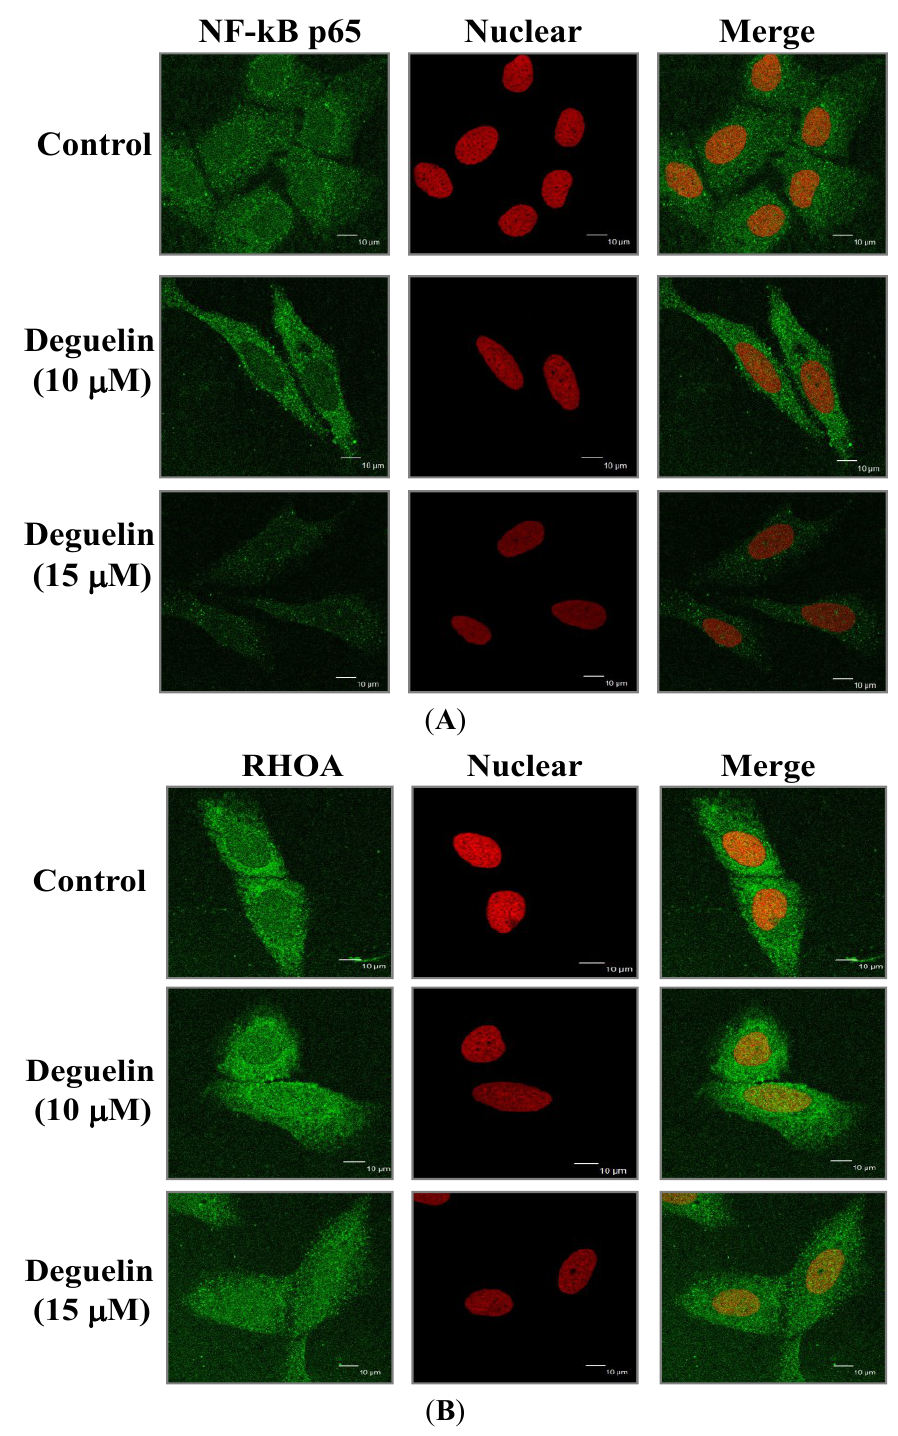
Figure 7. Deguelin affects the NF-κB p65, Rho A and ROCK-1 expression in U-2 OS cells. Cells placed on 6-well chamber slides were treated with 10, 15 μM of deguelin for 24 h, fixed and stained using anti-NF-κB p65 ( A ), Rho A ( B ) and ROCK-1 ( C ) antibodies (1:200) overnight and then stained with a secondary antibody (FITC-conjugated goat anti-mouse IgG at 1:200 dilution) (green fluorescence) followed by nuclear counterstaining individually performed with PI (red fluorescence). Photomicrographs were obtained using a Leica TCS SP2 confocal spectral microscope as described in the Experimental